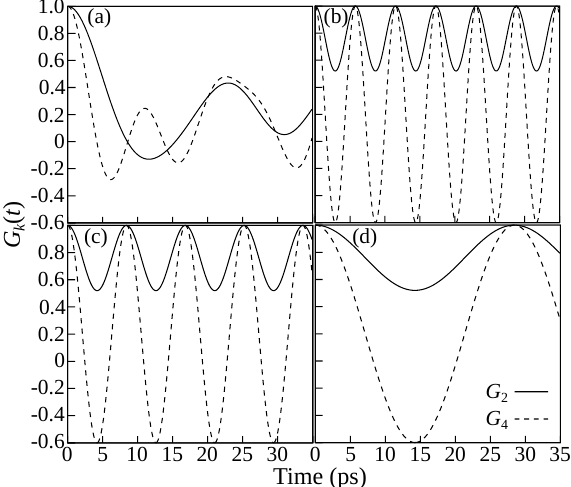
Figure 4. Individual G k ( t ) plots for Fe ion (a) F-like 2 p 3 / 2 , (b) F-like 2 p 1 / 2 , (c) Na-like 3 s 1 / 2 , and (d) Na-like 3 p 1 / 2 . These are